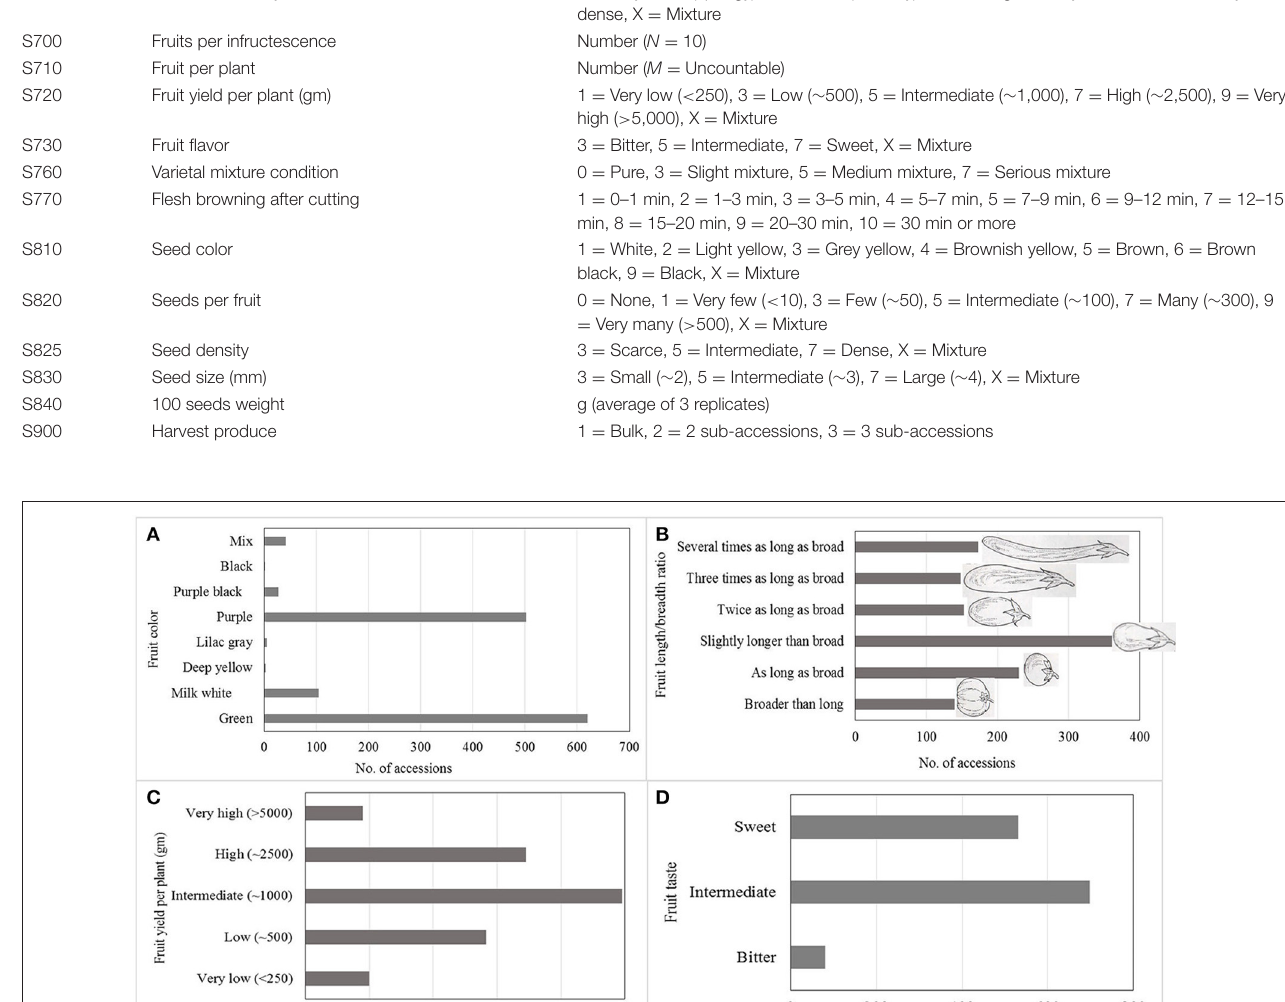
Frontiers in Plant Science |